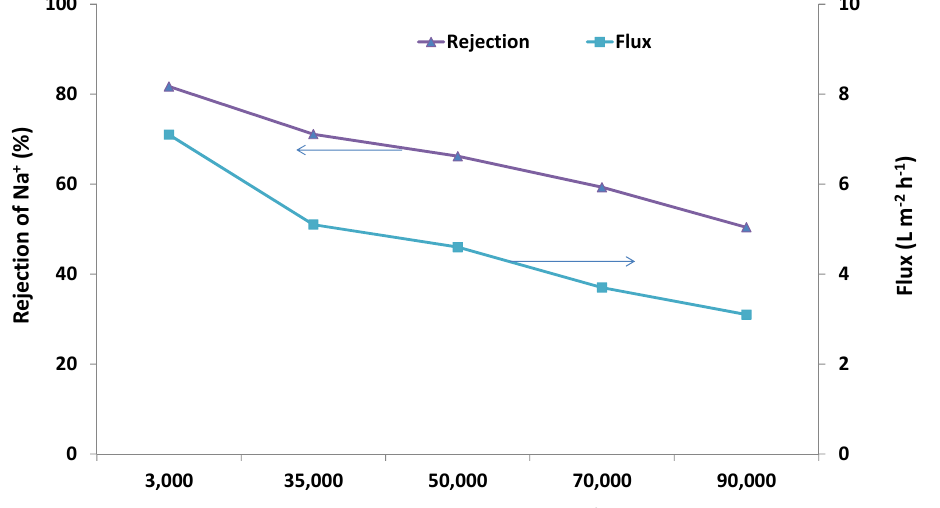
Figure 2. Na + rejection and flux on the zeolite membrane for the feed solutions with different NaCl concentrations (TDS 3000 to 90,000 mg·L − 1 ) at an applied gauge pressure of 7 MPa and 21